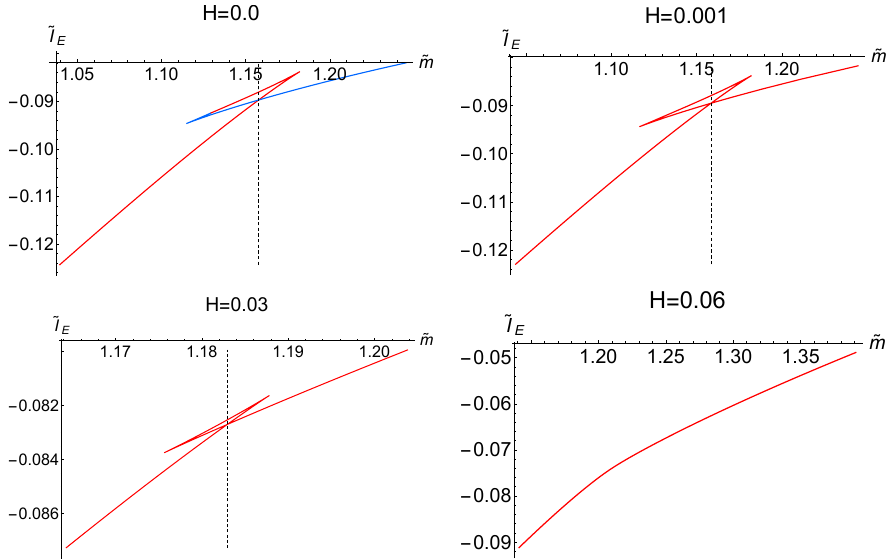
Figure 4. Plots of ~ I E as a function of the bare mass parameter ~ m . For small H there is a clear (cid:12)rst order phase transition pattern, which is less pronounced as H and for larger H is replaced by a crossover.